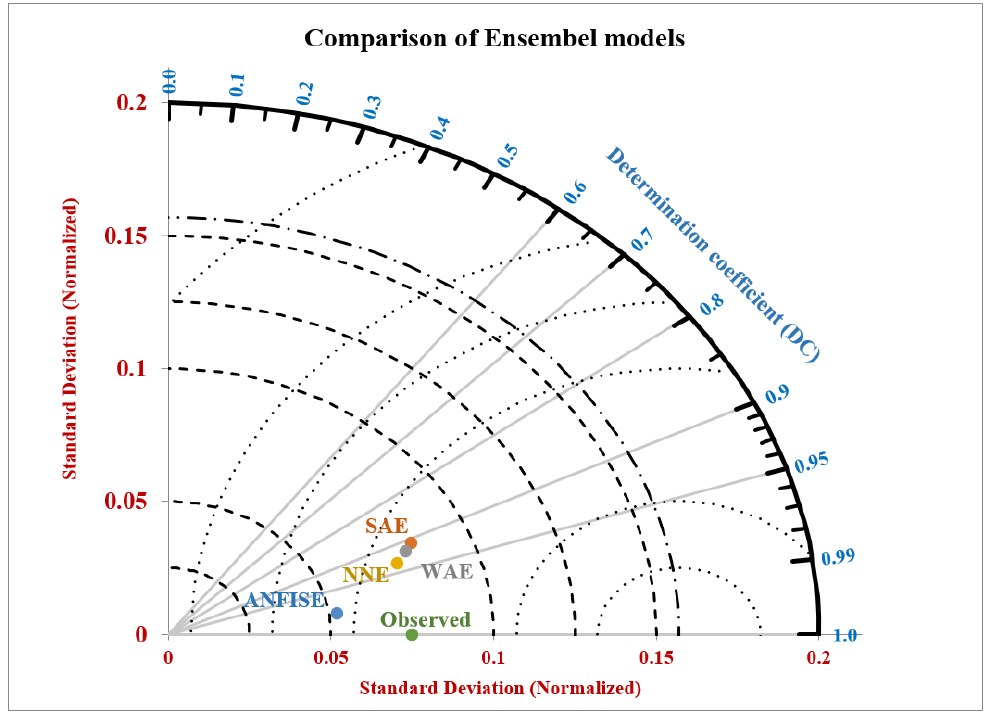
Figure 8. Performance of ensemble models using a normalized Taylor diagram.